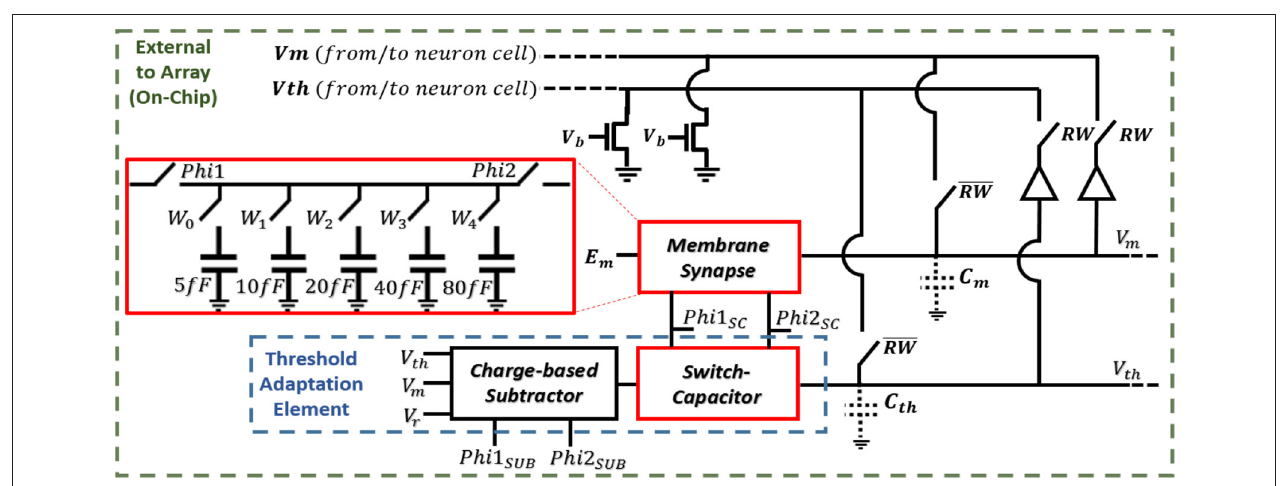
FIGURE 3 | Block diagram of the processor including the synapse and threshold adaptation